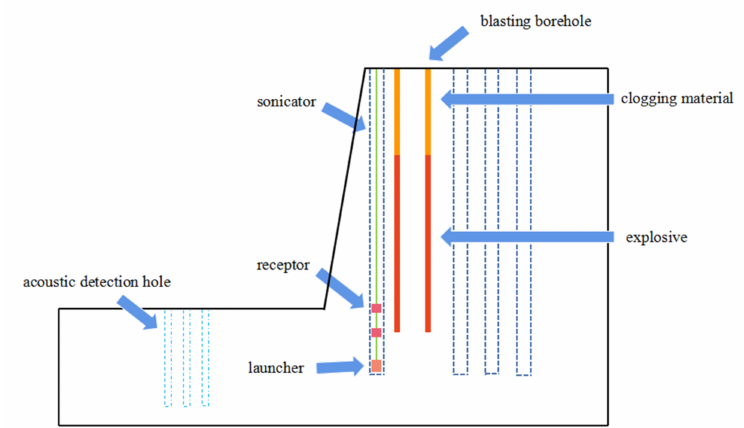
Figure 1. Field blasting and acoustic wave layout diagram.